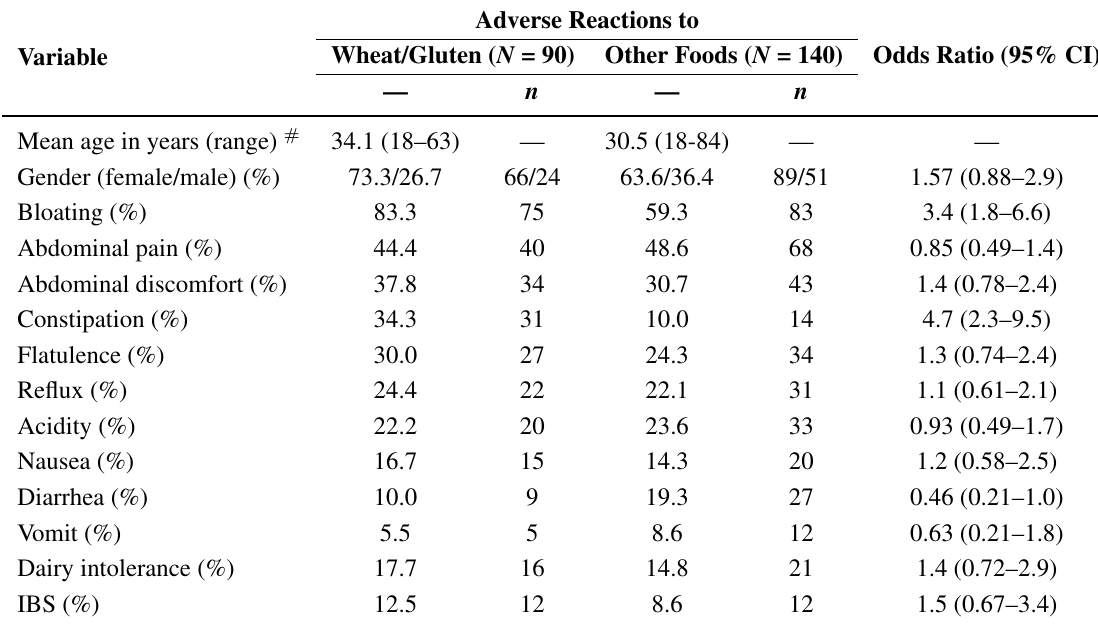
Table 4. Comparison between identified self-reported recurrent adverse reactions to gluten and recurrent adverse reactions to other foods cases.